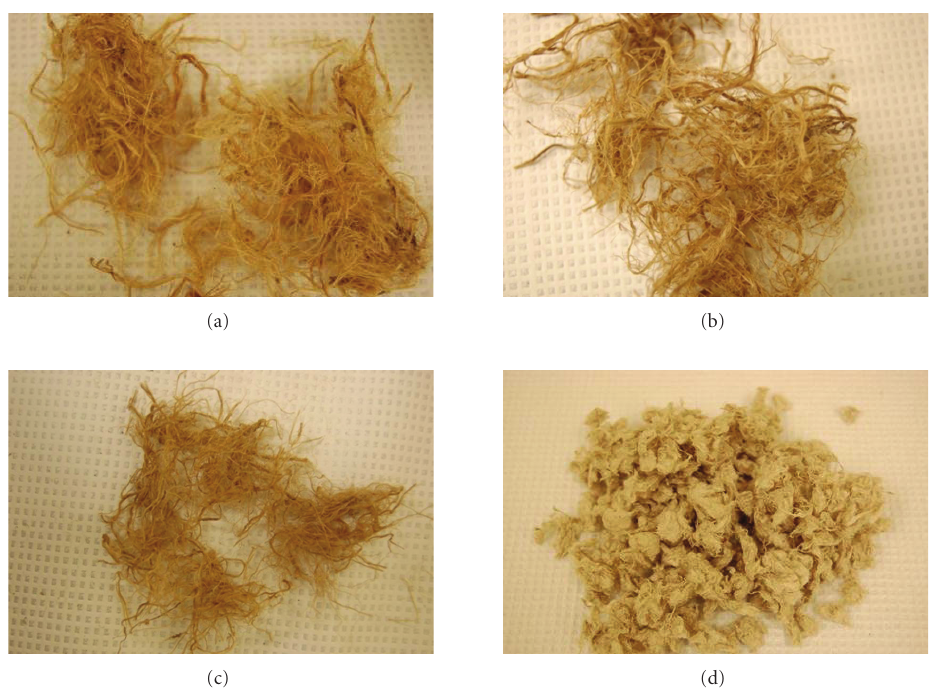
Figure 1: Images of the fibers digested at (a) 80 ◦ C, (b) 110 ◦ C, (c) 130 ◦ C, and (d) 160 ◦ C.